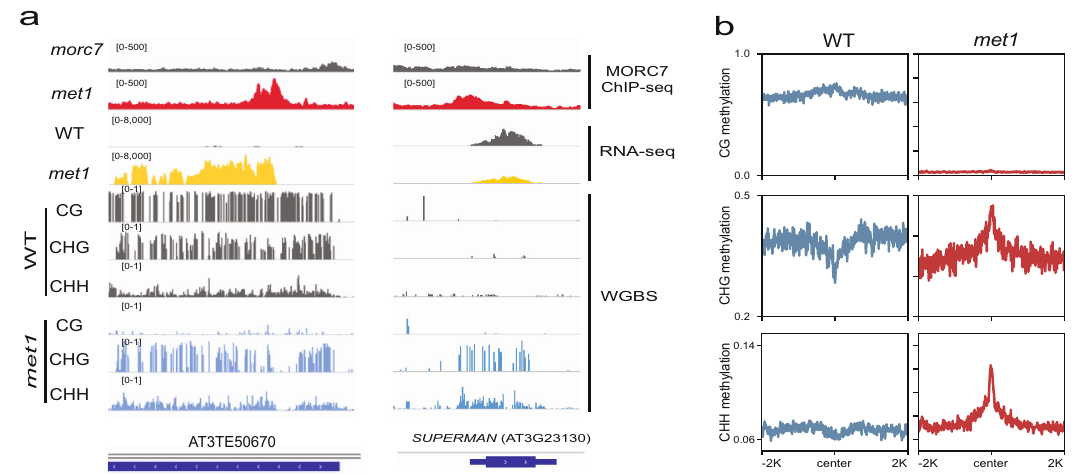
Fig. 4 MORC7 is recruited to ecotpic RdDM sites in met1. a Screenshot of one locus that ectopically gained MORC7 in met1 over a reactivated TE (left) and another example of ectopically gained MORC7 in met1 over the SUPERMAN locus. Expression level of the corresponding TE in wild type (gray) and met1 (yellow) were included. Methylation level in the wild type and met1 were indicated in the bottom 6 tracks. b Methylation level over the ectopically gained MORC7 peaks in wild type (left) and met1